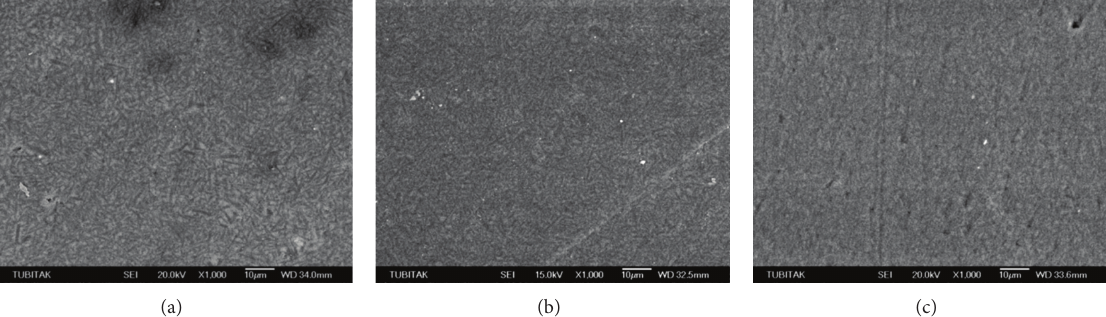
Figure 5: (a, b) Scanning electron micrographs of PE2-C and PE2-DT groups revealed crystals that are characterized by a needle-like morphology while PE2-TP (c) showed some scratch lines.